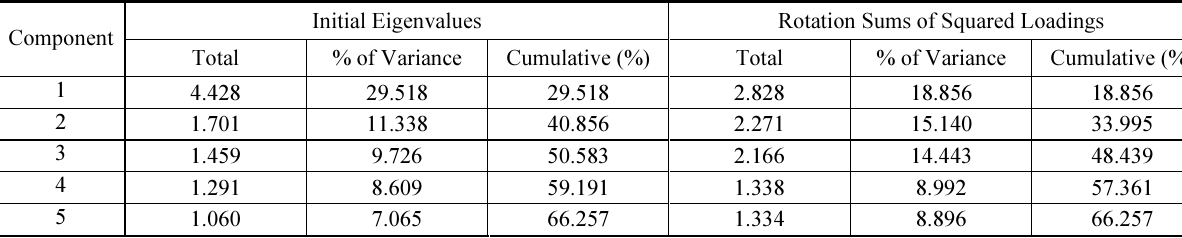
Table 7. Total Variance Explained by Principal Component Analysis